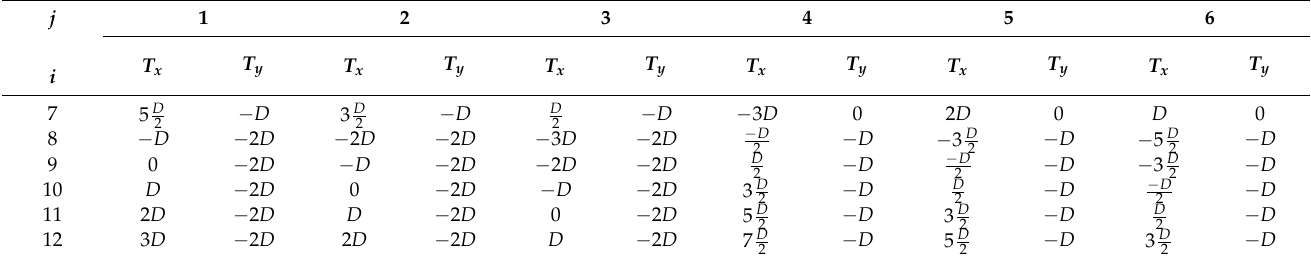
Table 5. Final formation distance in the 12-robot experiment of robots 7–12 for robots 1–6.